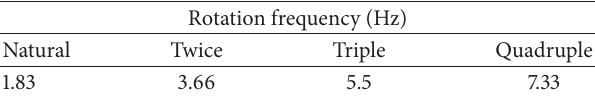
Table 1: Frequencies of the spindle